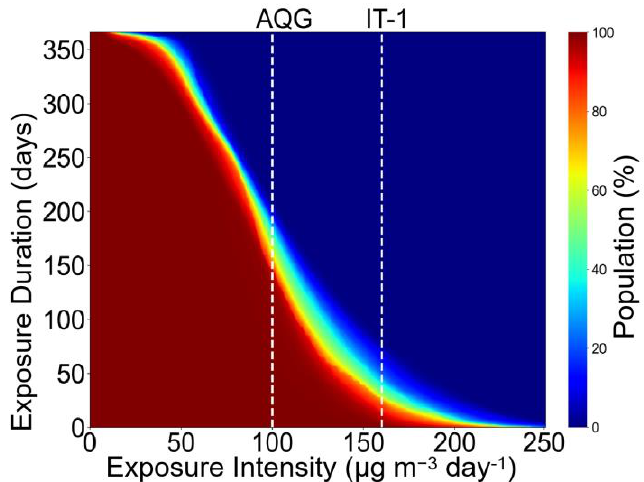
Figure 9. Cumulative distributions of daily mean exposure to O 3 . The two white dotted line are air quality guideline (AQG: 100 µ g m − 3 ) and interim target 1 (IT1: 160 µ g m − 3 ),